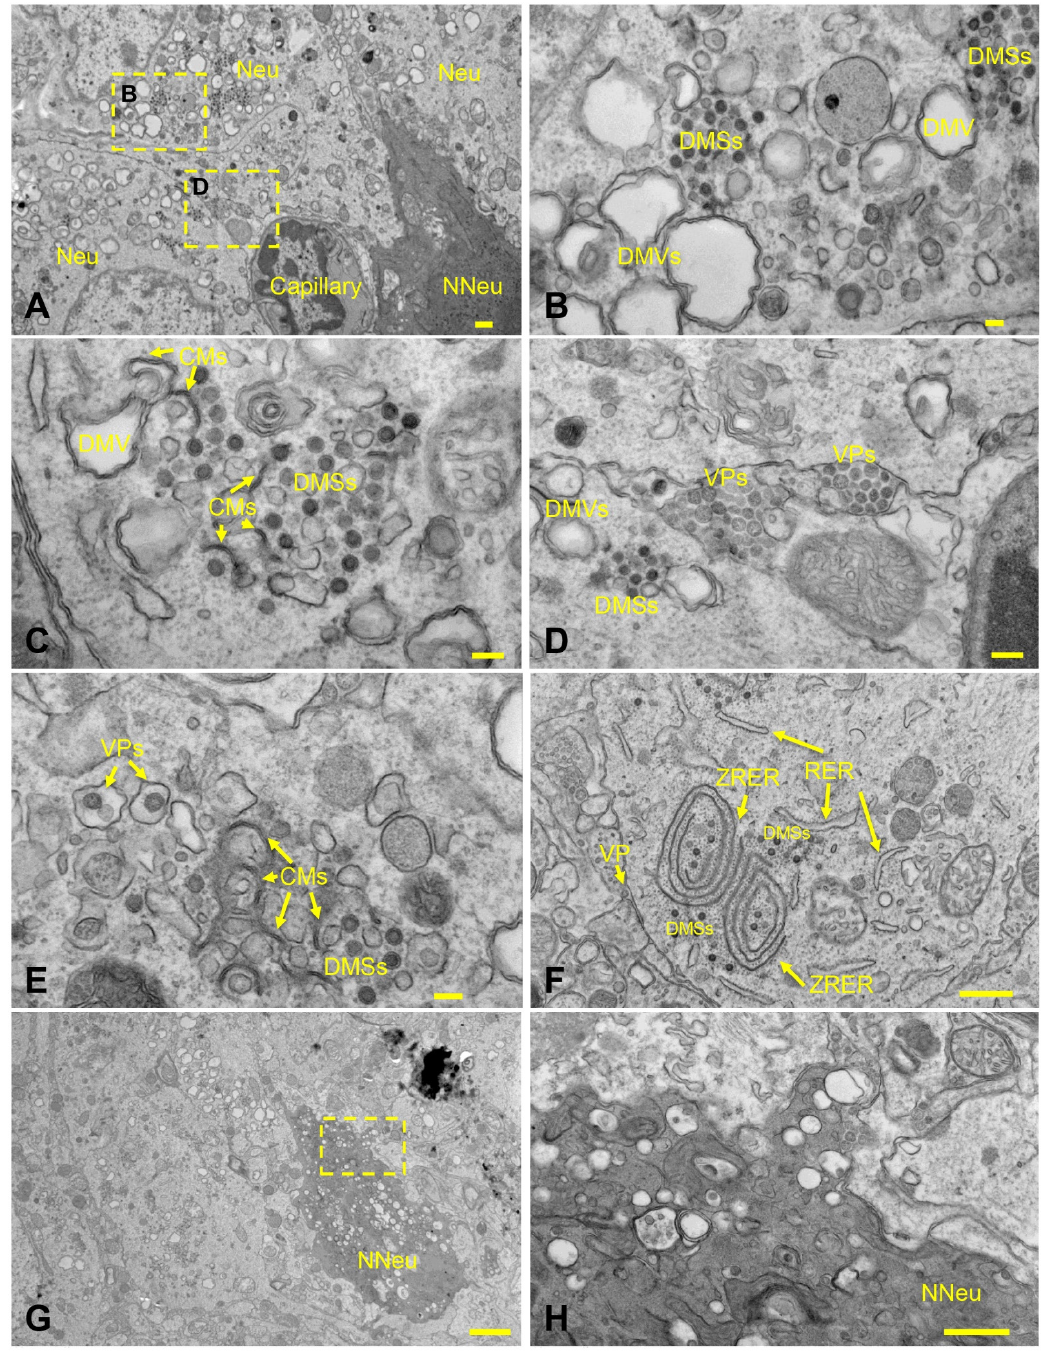
Figure 8. Ultrastructural features of SARS-CoV-2-infected neurons. ( A ) Neurons (Neu) contain abundant intracytoplasmic viral particles and various replication-associated intracytoplasmic mem- branous structures. Necrotic neurons are diffusely electron dense (NNeu). ( B ) Higher magnification of the squared area on ( A ) depicting double-membrane vesicles (DMVs) and spherules (DMSs). ( C ) Cubic membranes (CMs) are also noted among DMVs and DMSs. ( D ) Higher magnification of the squared area on ( A ). Mature viral particles are indicated as VPs. ( E , F ) VPs are associated with membranous structures related to viral replication (DMVs, DMSs and CMs) and with the rough endoplasmic reticulum (RER). ( G ) Necrotic neurons (NNeu) are diffusely electron dense and contain numerous cytoplasmic vacuoles. ( H ) Higher magnification of squared area on ( G ). Note the high cytoplasmic electron-density. Scale bars = 100